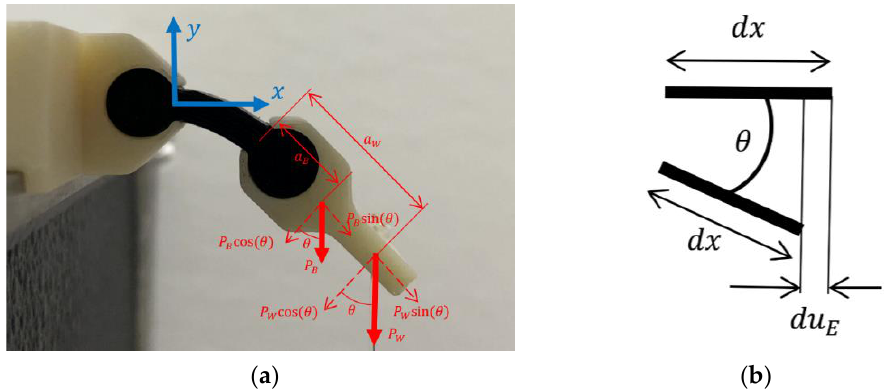
Figure 5. Specimen diagrams. ( a ) Diagram of experimental system: 𝑃 𝑤 is the load applied, 𝑃 𝐵 is the load applied by the weight of the bracket. The lengths 𝑎 𝐵 and 𝑎 𝑊 represent the moment arms for each respective load. The angle 𝜃 is equivalent to tan −1 (𝑣 𝑥 (𝑙)) at the tip of the beam. ( b ) Retraction of a differential element on inextensible beam.